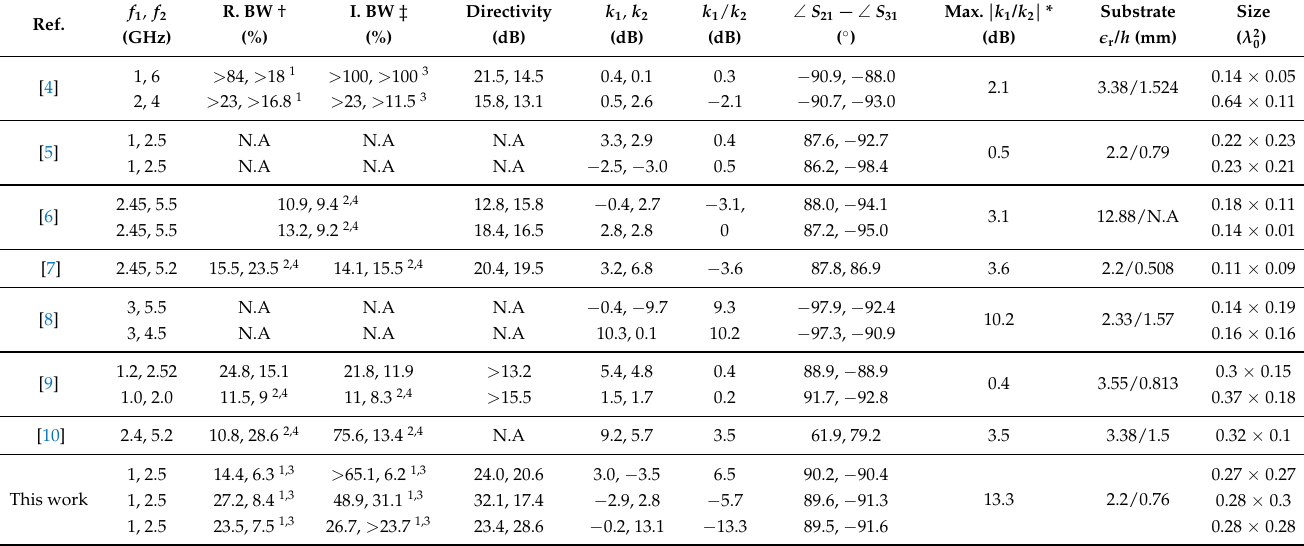
Table 2. Summary and comparison of measured